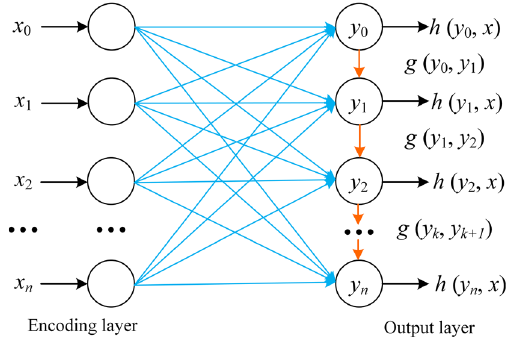
Fig. 6 Structure of fully connected condition random field